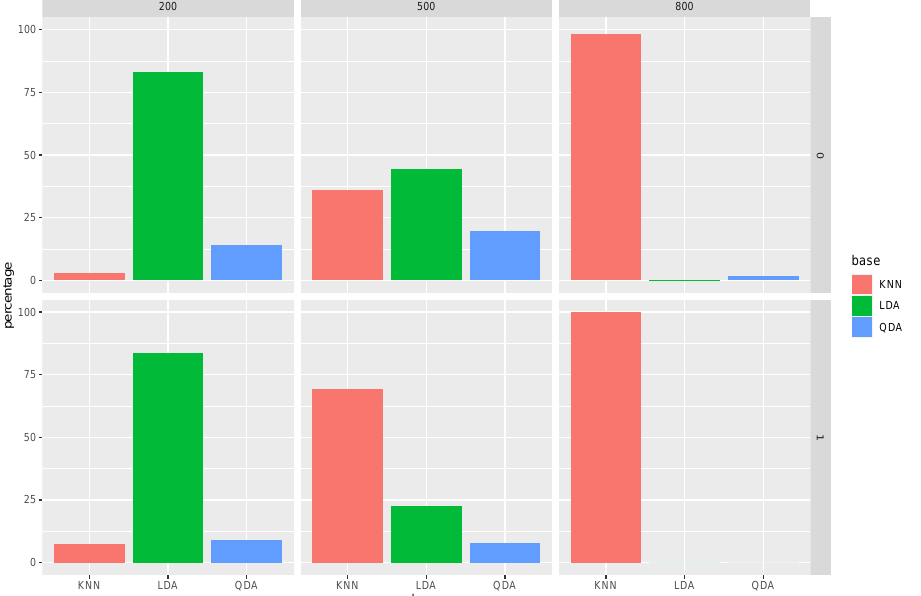
Figure 7. The average selected proportion for each base method for different sample sizes (corre- sponding to each column) and iteration number (corresponding to each row) for the mice protein expression data.